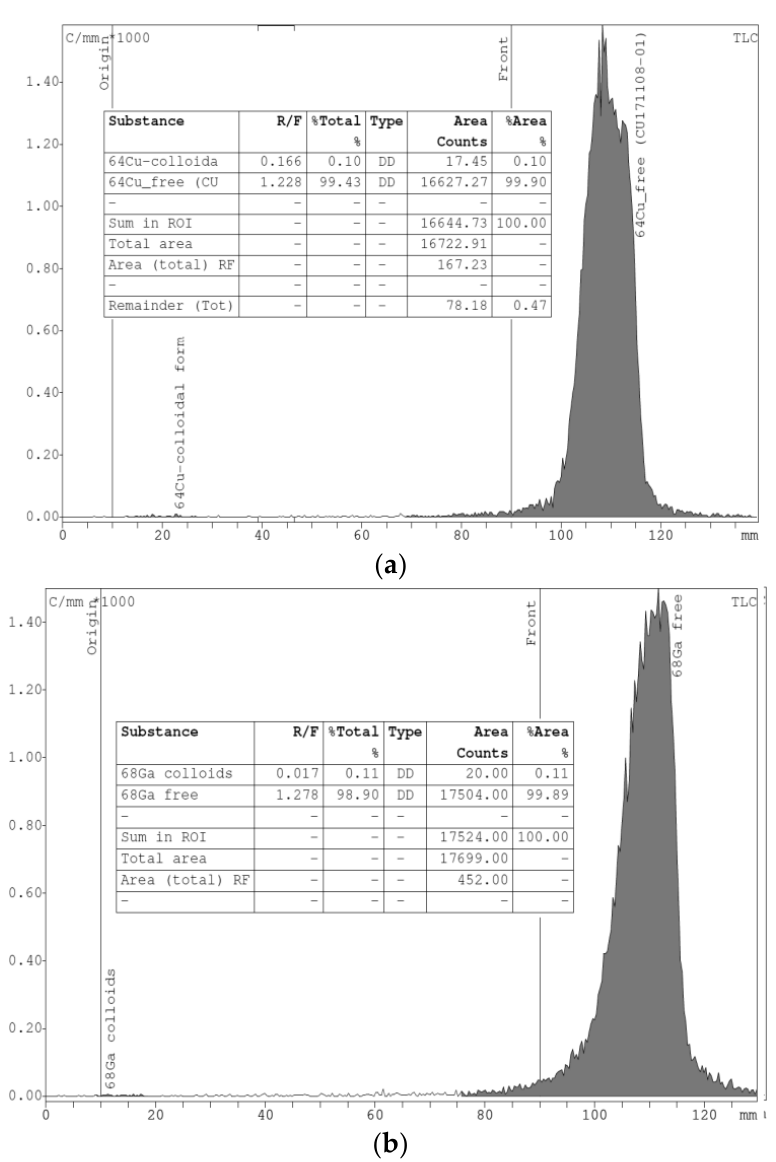
Figure 6. iTLC analysis of purified 64 CuCl 2 ( a ) and 68 GaCl 3 ( b ) using a Raytest miniGita detector. Stationary phase: iTLC-SG strips; mobile phase: 0.1 M sodium citrate (pH adjusted to 4–4.5). Rf = 0.1–0.2 for colloidal form and Rf = 1.0 for free radioisotope.